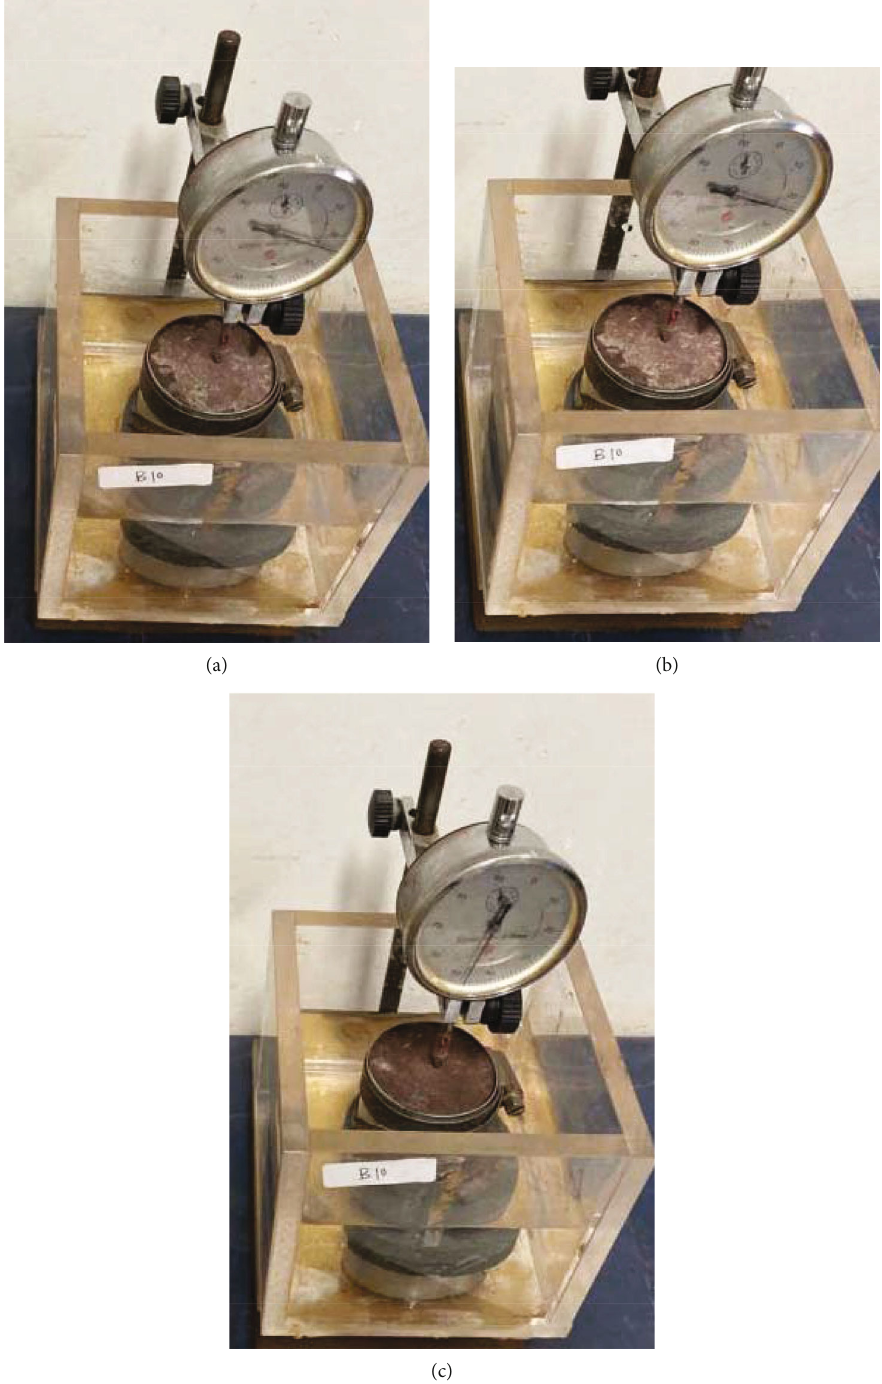
Figure 8: Snapshots of partial immersion deformation: (a) immersion for 1 min, (b) immersion for 15 min, and (c) immersion for 3